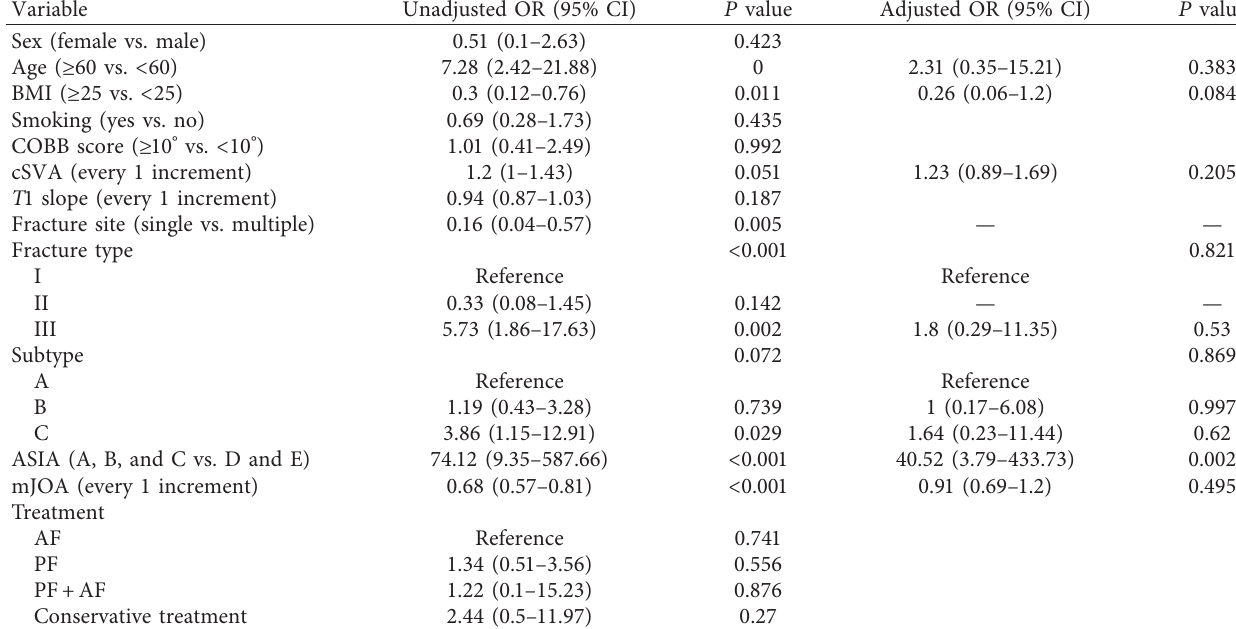
Table 2: Logistic and ASIA.